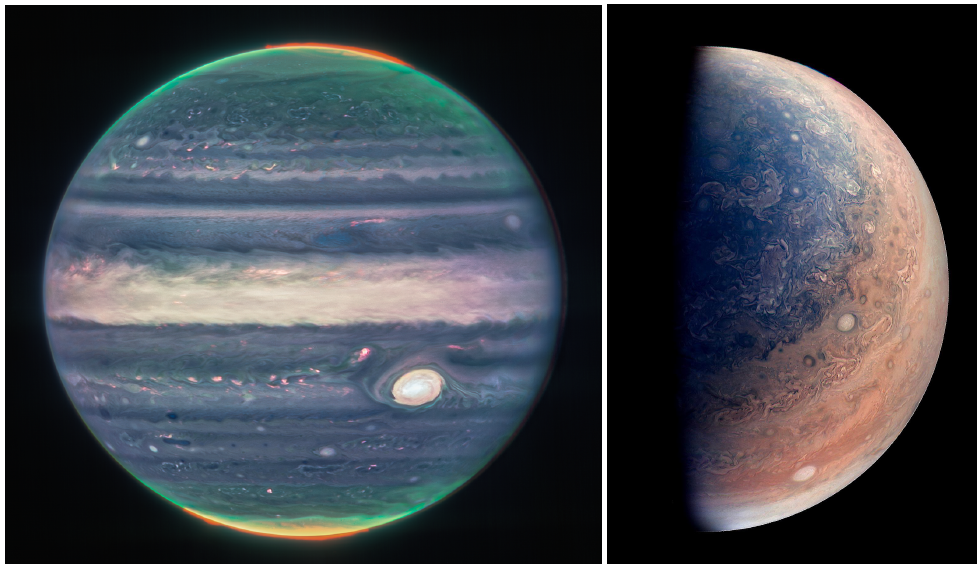
Figure 1. ( Left ) Jupiter’s atmosphere at the equator observed with JWST/NIRCam. ( Right ) South pole of Jupiter observed by JUNO/NASA. We see the differences in the dynamics between the poles and the region at lower latitudes. When large east–west jet stream structured the planet from the equator to the tropics, the poles show a lot of turbulence and storms without global structures. This is due to the high variation in the atmosphere (in term of dynamics, composition, clouds, etc.) according to latitude and longitude, which thus cannot be reproduced well using 1D